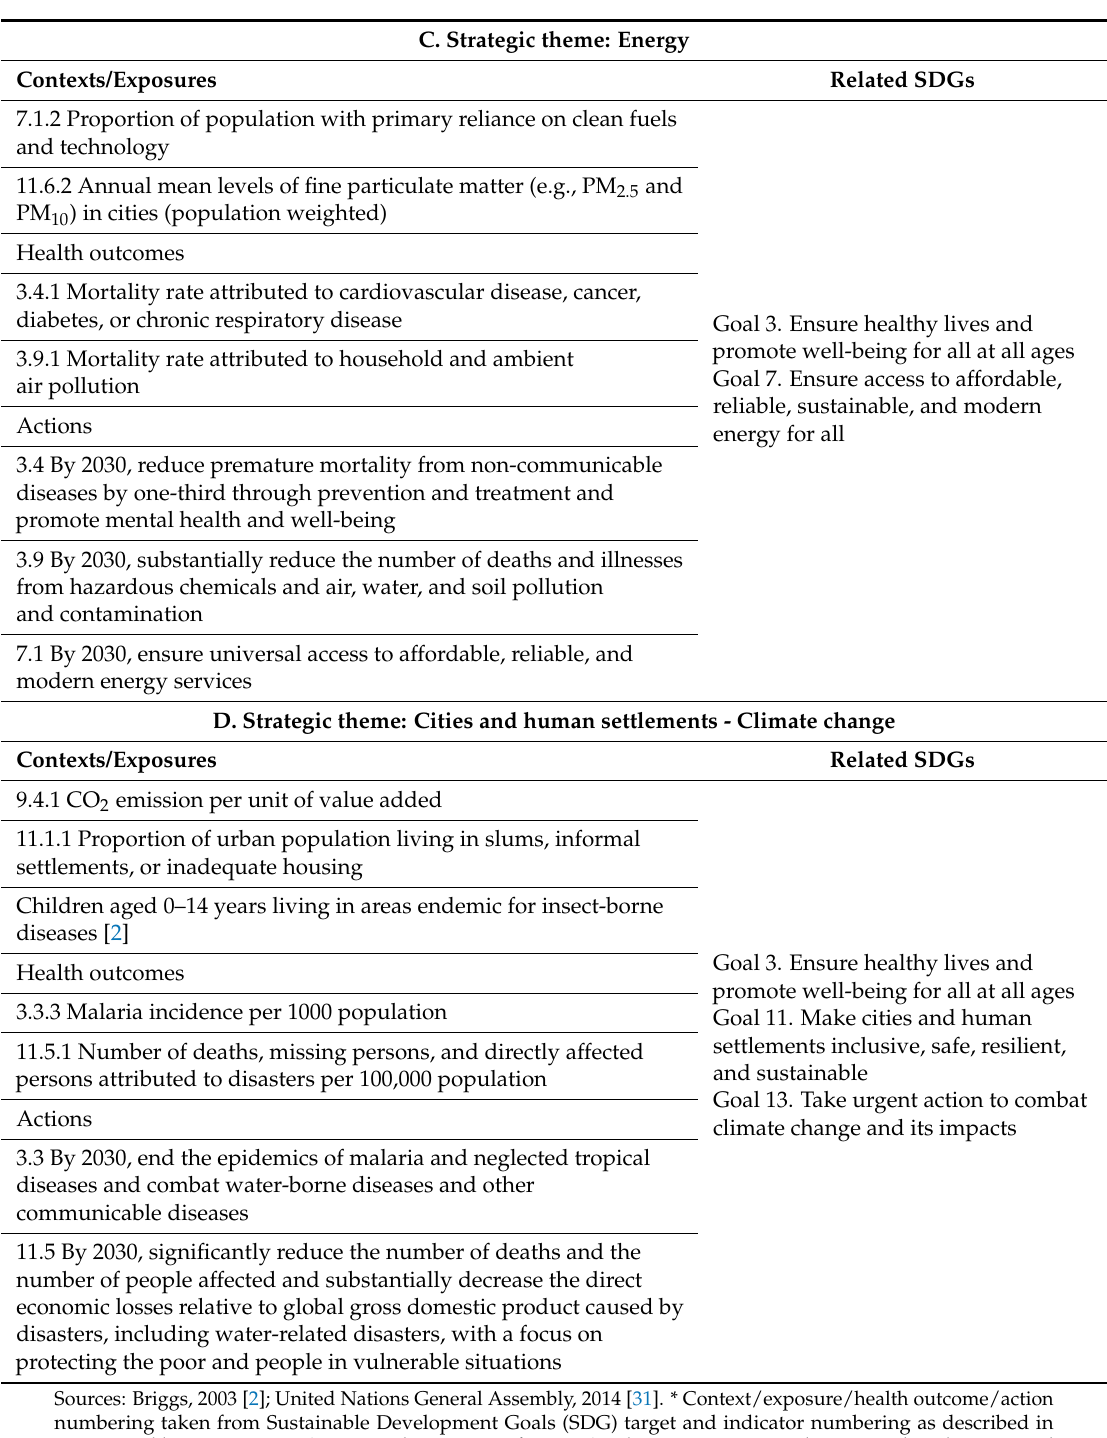
Figure 1. Abbreviations: AIDS, Acquired Immune Deficiency Syndrome; PM 10 , particulate matter less than or equal to 10 µ m in diameter; PM 2.5 , particulate matter less than or equal to 2.5 µ m in